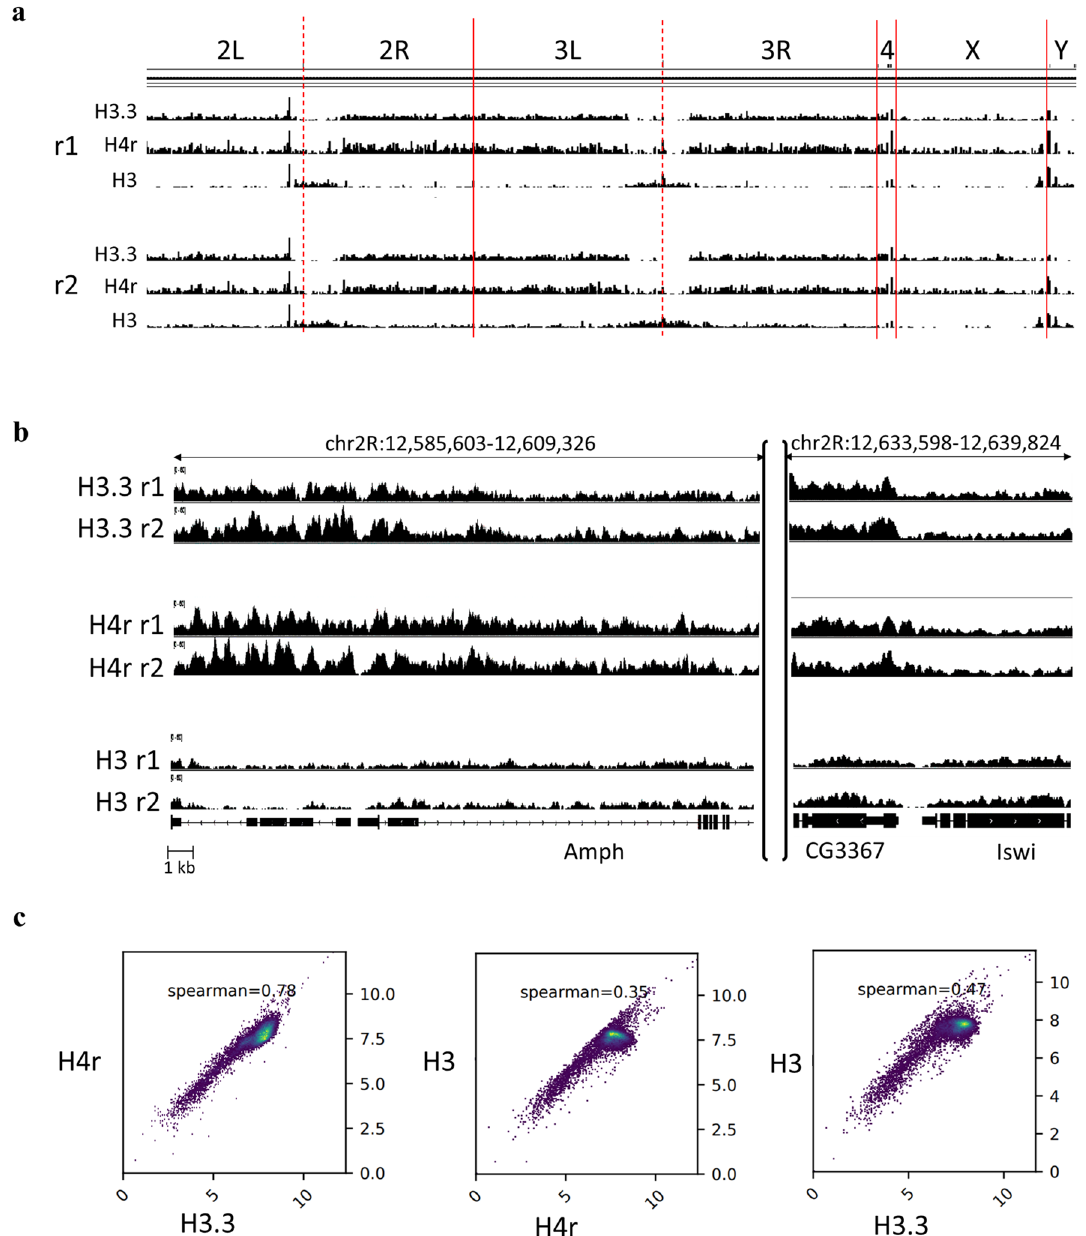
Figure 4. Comparison of genome-wide distribution of H4r, H3.3 and H3. ( a ) Genome-wide distribution of H3.3, H4r and H3 as determined by replicates of ChIP-seq experiments. On the top the extensions of individual chromosomes are shown, the graphs indicate the detected frequencies of localization distribution of the indicated proteins. Note that H3.3 and H4r were both detected by Flag specific antibody while H3 was detected a specific antibody, which also recognise H3.3. ( b ) H3.3, H4r and H3 localization at specific genome regions. r1: replicate 1, r2: replicate 2. ( c ) Spearman correlation scatterplots of H4r, H3.3 and H3 ChIP-seq